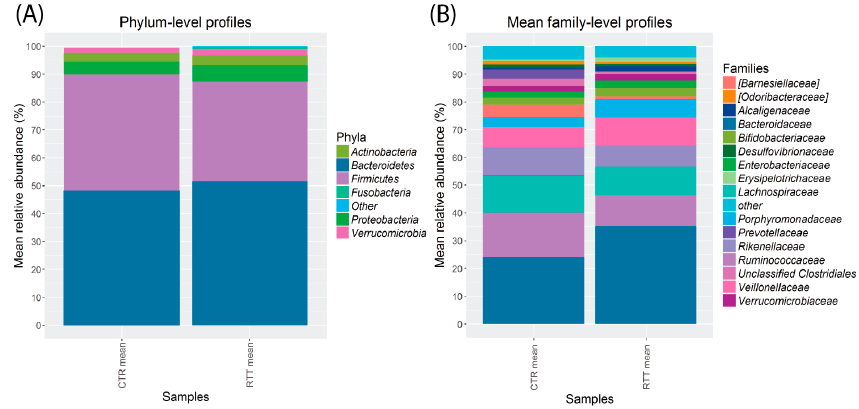
Figure 3. Bar charts representing the average relative abundance of Rett (RTT, n = 8) and control (CTR, n = 10) microbiota, classified using the 16S rRNA gene. ( A ) Mean relative abundances of fecal bacterial phyla; ( B ) Mean relative abundances of fecal bacterial families.